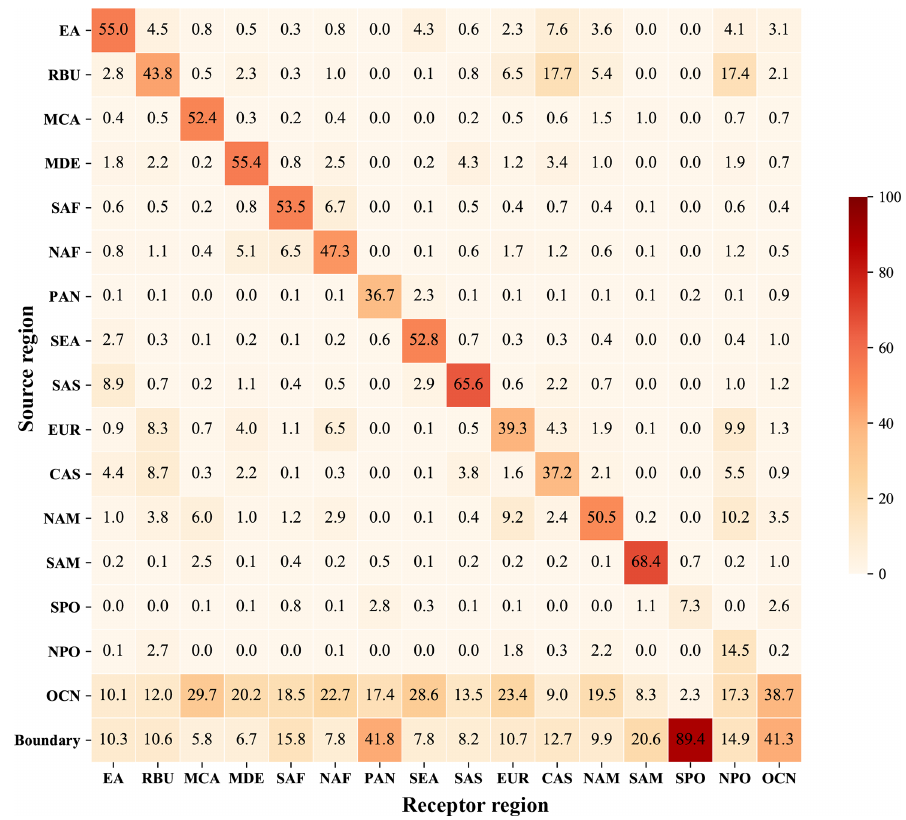
Figure 14. Annual estimates of the contributions to surface O 3 (%) from source regions to receptor